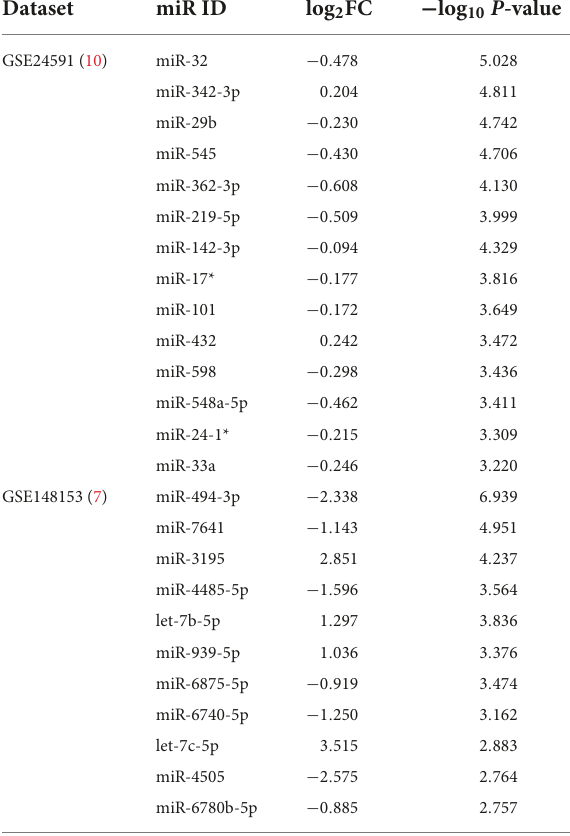
TABLE 2 Differentially expressed miRs ( p < 0.01) obtained from the datasets expressed as log fold change (log 2 FC) and –log10 p -value.